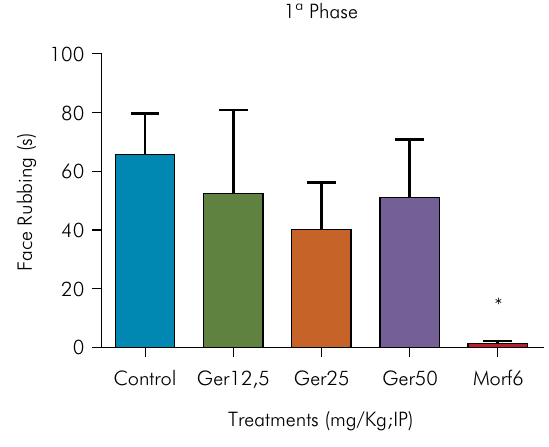
Figure 3. Effect of geraniol on formalin-induced nociception. Control (0.2% Tween 80); geraniol (12.5, 25 and 50 mg/kg IP); morphine (6 mg/kg IP). Values are expressed as the mean ± SD (n = 7 in each group); p* = 0.001 versus control (one-way ANOVA, followed by the t-test for heterogeneous variances).